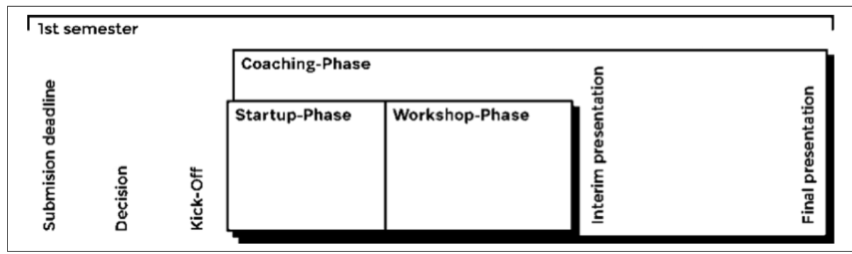
Fig. 1. Structure of the Gruendungsgarage